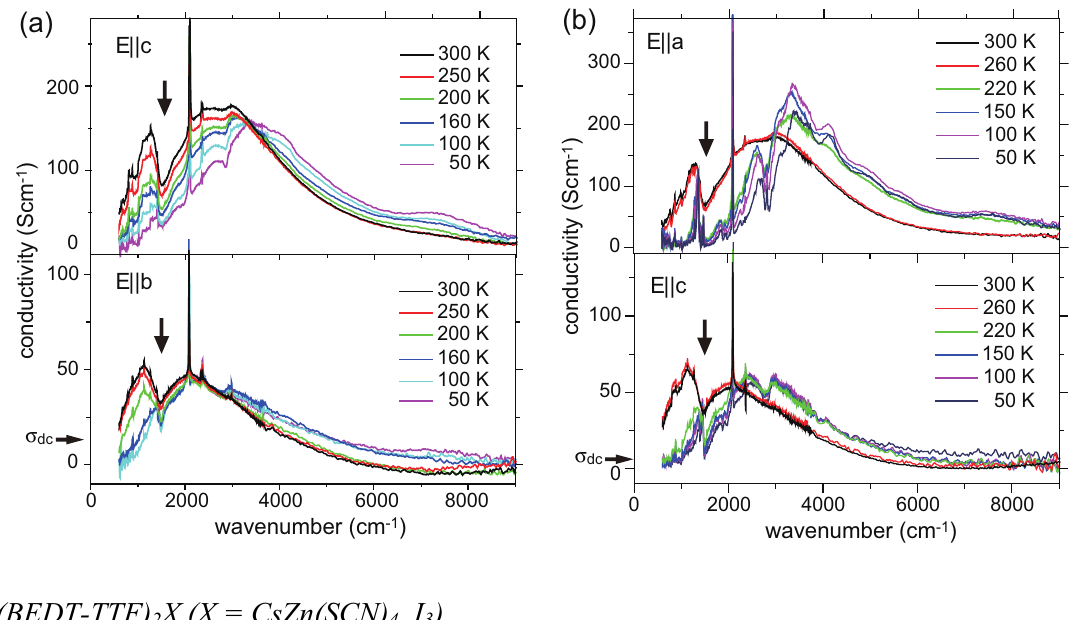
Figure 15. Optical conductivity of ( a ) θ TlZn(SCN) . Note that the spectral variation is discontinuous in θ TTF) 2 4 , whereas it is continuous in θ TlZn(SCN) 4 the vibronic band of ν 3